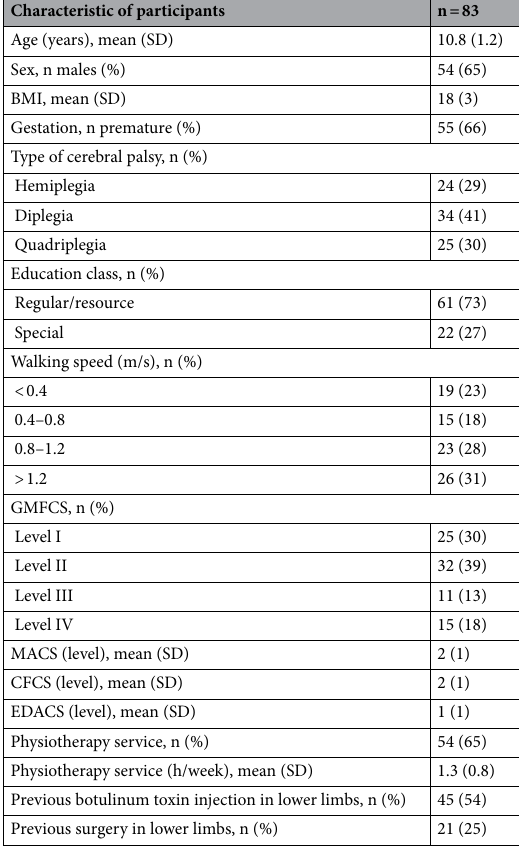
Table 1. Characteristics of participants. GMFCS Gross Motor Function Classification System, MACS Manual Ability Classification System, CFCS Communication Function Classification System, EDACS Eating and Drinking Ability Classification